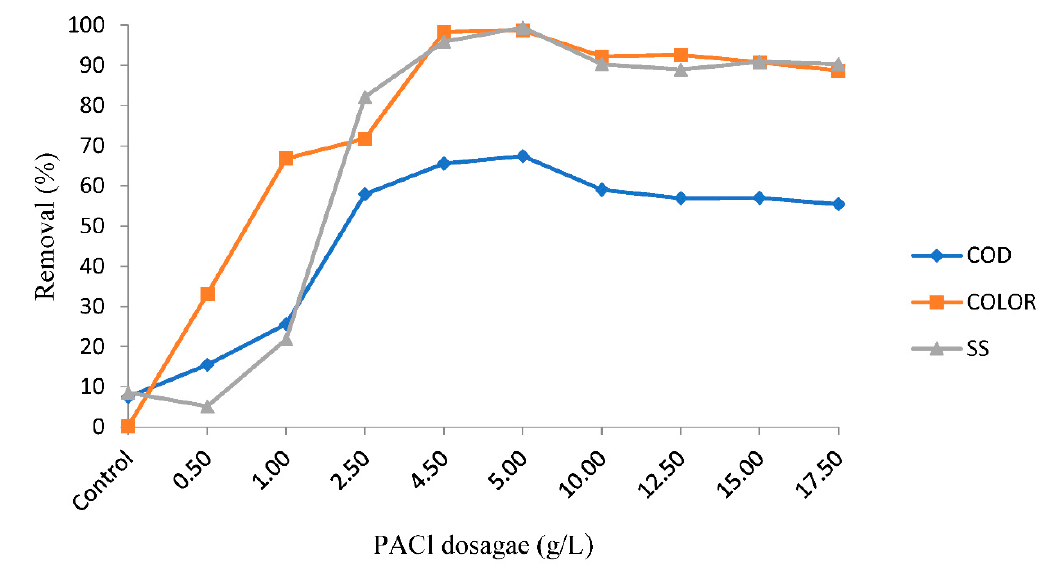
Figure 6. The effect of PACl in major range of dosage on the removal of COD, color and SS at pH 6.